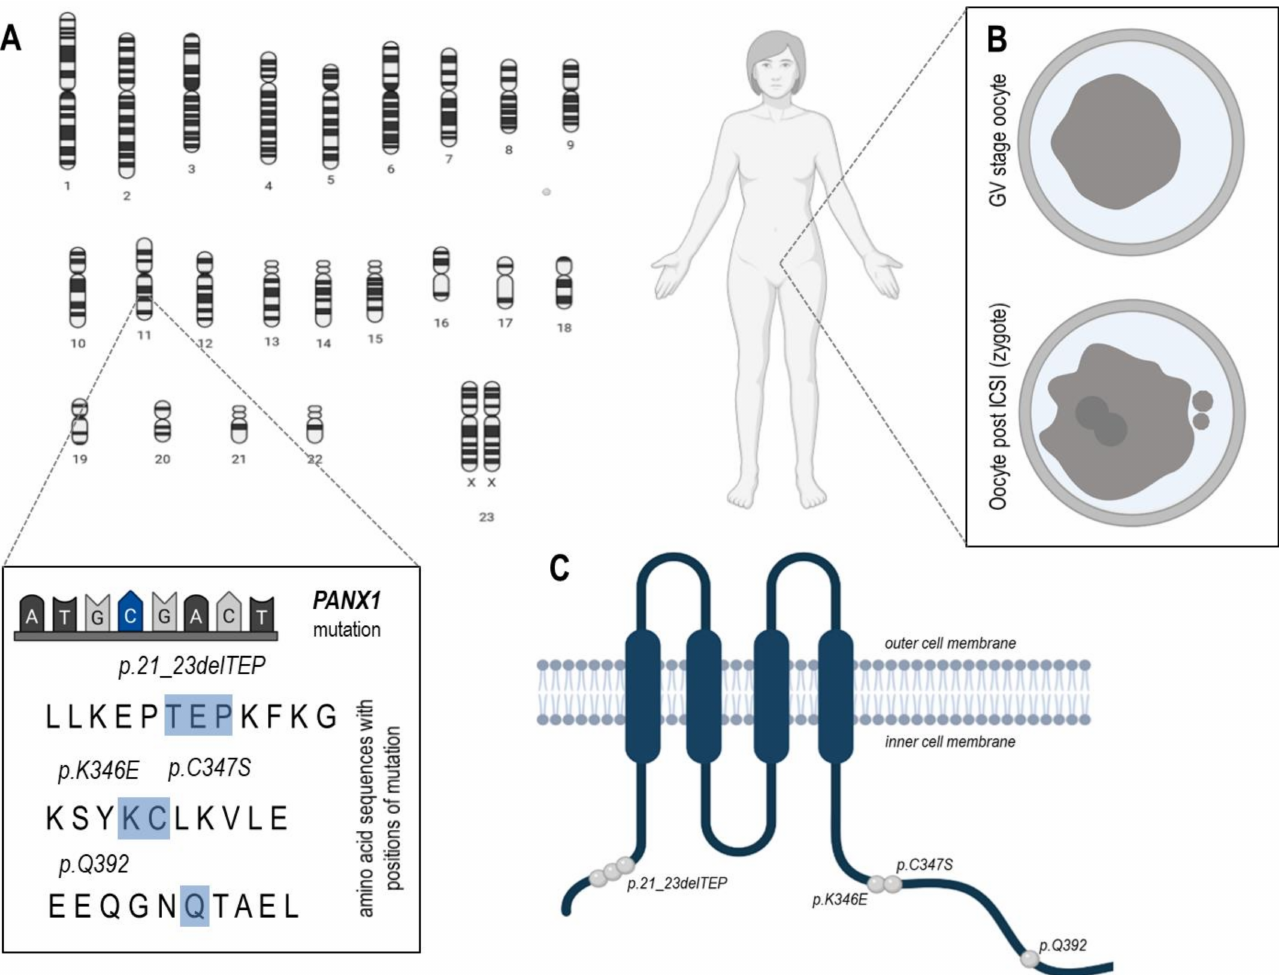
Figure 3. Mutation distribution of PANX1 and morphological appearance of oocytes retrieved from PANX1 channelopathy patients. ( A ) The gene Panx1 which encodes for PANX1 is located on chromosome 11 in humans. In four investigated families, four different mutations loci have been identified which led to a change in the amino acid sequence (highlighted in blue). ( B ) The upper part shows an exemplary degenerated oocyte in the germinal vesicle (GV) stage with shrunken ooplasm (dark grey), directly after oocyte retrieval; the lower part shows an exemplary degenerated zygote (fertilized oocyte) 30 h after Intra-Cytoplasmic-Sperm-Injection = ICSI, with the two pronuclei and extruded polar-bodies visible, but all specimens died at this stage. ( C ) Distribution of four disease-causing mutations in PANX1. All mutations were located in the cytoplasmic region and are highlighted as grey dots (according to